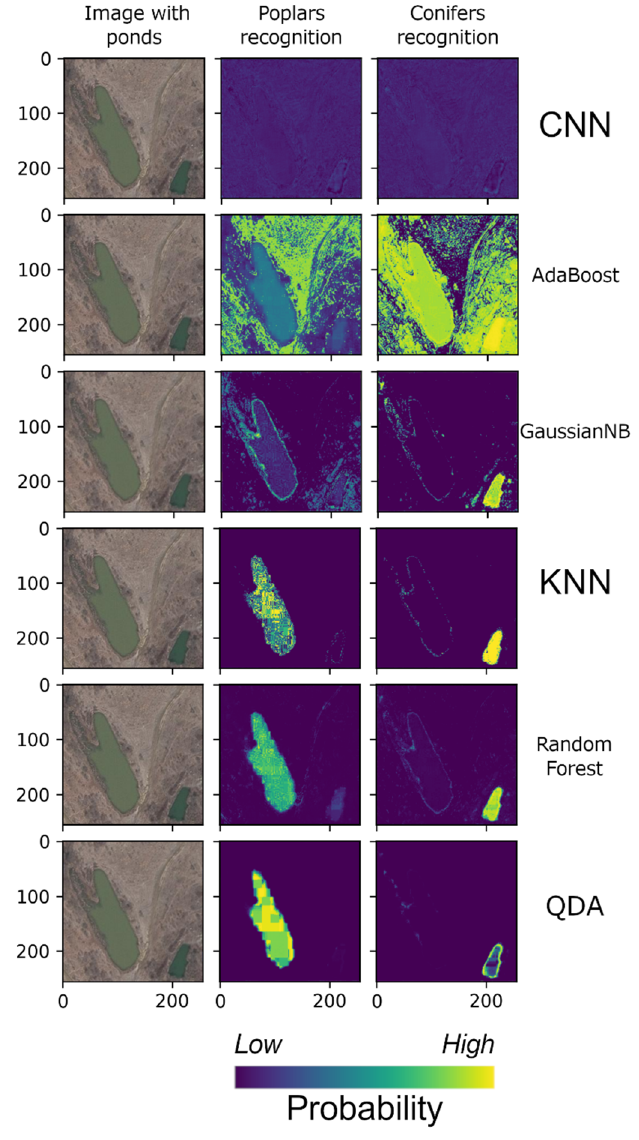
Figure 4. Comparison of pixel-based and U-Net-like CNN algorithm recognition results. Segmentation algorithms: CNN—U-Net-like CNN; AdaBoost—adaptive boosting classifier; GaussianNB— naive Bayes classifier; RandomForest—random forest classifier; KNN— k -nearest neighbors classifier;